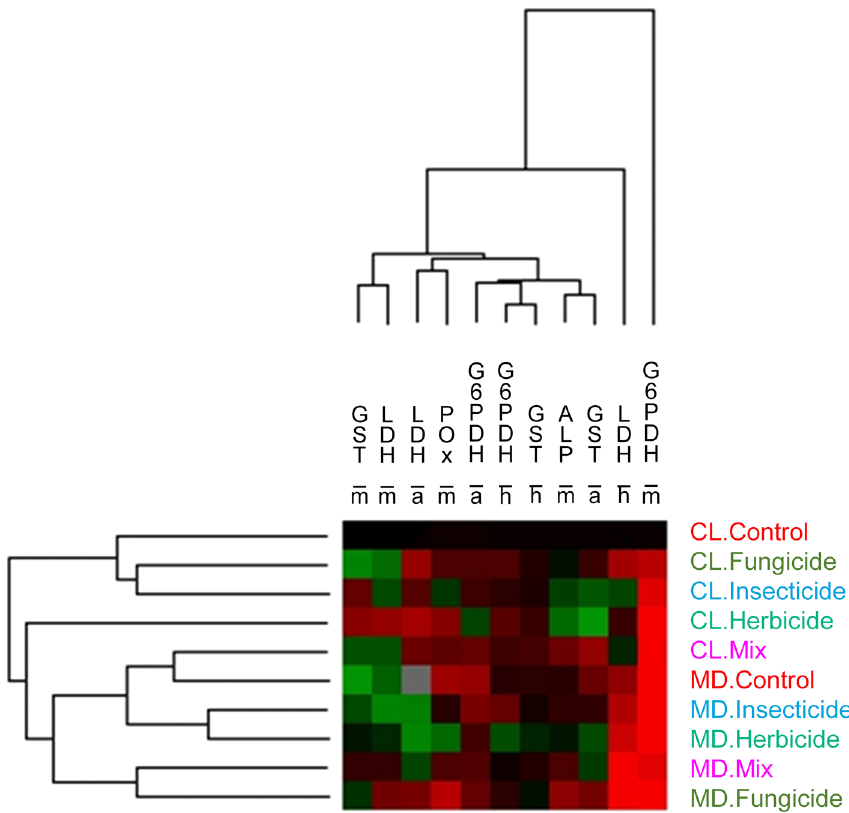
Figure 3. Effects of the pesticides and gut colonization on the physiological state of honey bees. The levels of physiological markers in colonized (CL) and microbiota-depleted (MD) newly emerged honey bees exposed or not to pesticides was submitted to a cluster analysis to assess, with an integrative approach, the effect of pesticide treatments and gut colonization status on the physiological markers analyzed in the head (h), abdomen (a) and midgut (m). Colonized (CL) and microbiota-depleted (MD) honey bees were fed sucrose solutions containing no pesticides (Control), imidacloprid (Insecticide), glyphosate (Herbicide), difenoconazole (Fungicide) or the ternary mixture (Mix) at concentration of 0.1 µg/L in food. The distance measured was Euclidian distance with UPGMA as the linkage rule for clusters. Data normalization was required to convert the mean of each treatment to the rate of variation compared with the average of the control (CL.Control). The intensity of modulation is illustrated by the range of colors, with green and red indicating respectively a decrease and an increase of the mean enzymatic activity in each treatment, by comparison with the mean value in the CL.Control. Black indicates no change by comparison with the mean value of